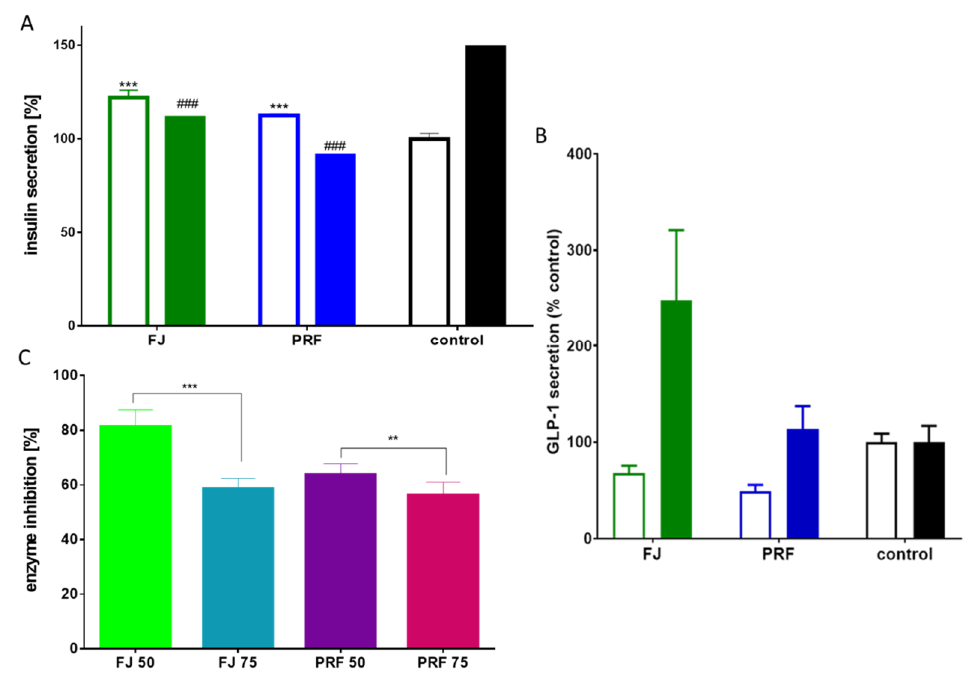
Figure 9. The influence of V. opulus extracts on insulin secretion by MIN6 cells ( A ), GLP-1 secretion in GLUTag cells ( B ) in low (open bars) or high (closed bars) glucose conditions. Control cells were not exposed to any compound but the vehicle; values are means ± standard deviations from at least three independent experiments, n ≥ 9; statistical significance was calculated versus control cells treated with low glucose *** p ≤ 0.001 or high glucose ### p ≤ 0.001. Percentage DPP4 enzyme inhibition by FJ and PRF ( C ); values are means ± SD, n ≥ 4; statistical significance ** p ≤ 0.01, *** p ≤ 0.001.